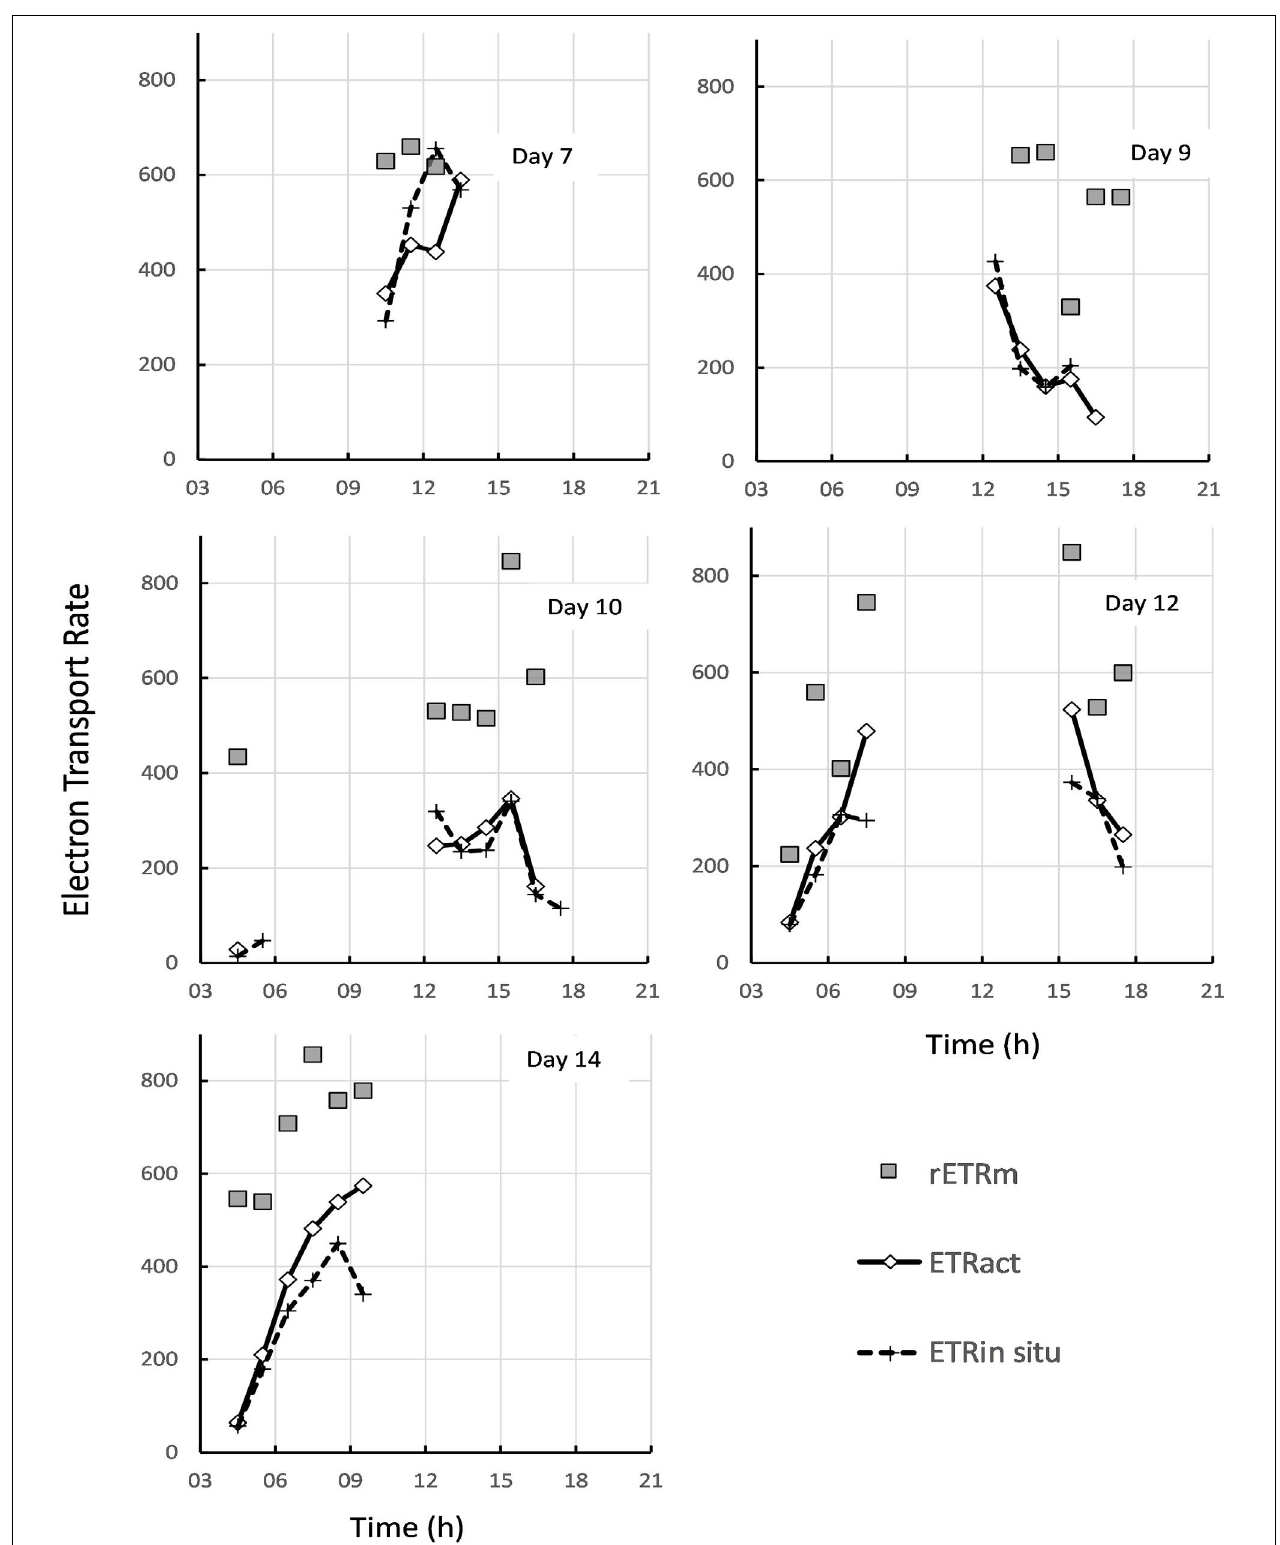
FIGURE 10 | Comparison of the theoretical maximum rate of electron transport rETR m estimated from rapid light curves (gray squares), with the estimated in-situ ETR in ambient light (gray diamonds), and the actual in-situ rate measured directly in ambient solar irradiance (dashed line with crosses).